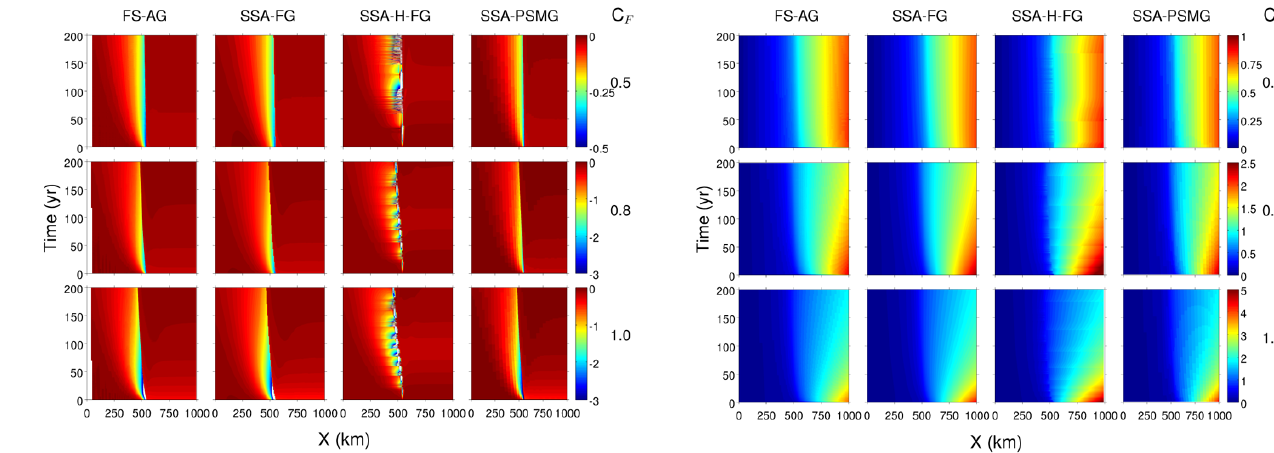
Fig. 4. Surface horizontal velocity (kmyr − 1 ) as a function of time and horizontal distance ( x = 0 corresponds to the ice divide and x f = 1000 km is the calving front) for the three buttressing values (lines) and for the four models